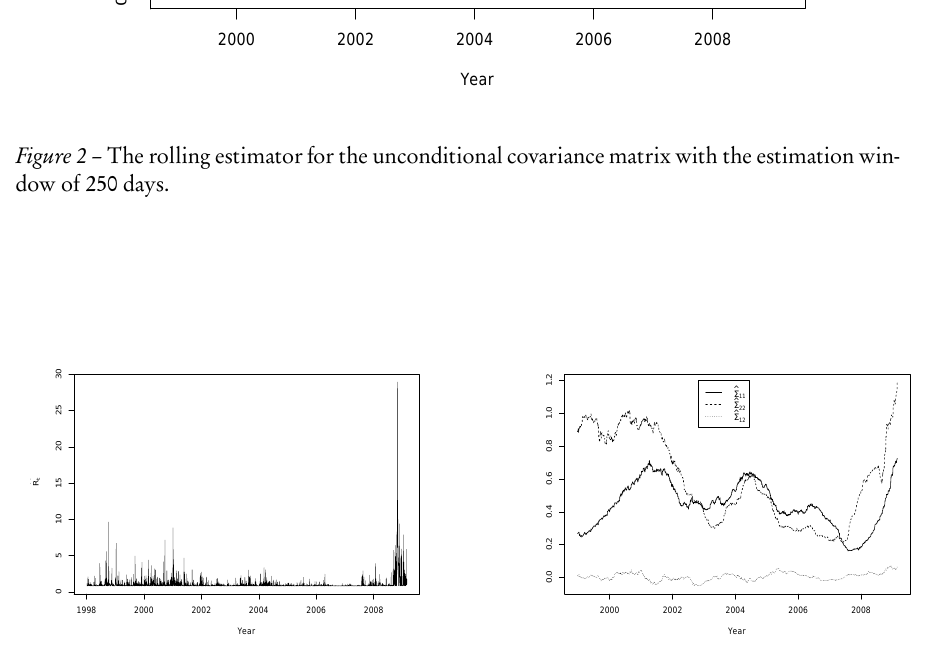
Figure 3 – Estimators for the generating variable and the dispersion matrix of the daily EUR / USA and EUR / JPY exchange rate returns for the period from January 2, 1999 to November 30, 2009. For estimating of the dispersion matrix the rolling estimator is used with the estimation window equals to 250